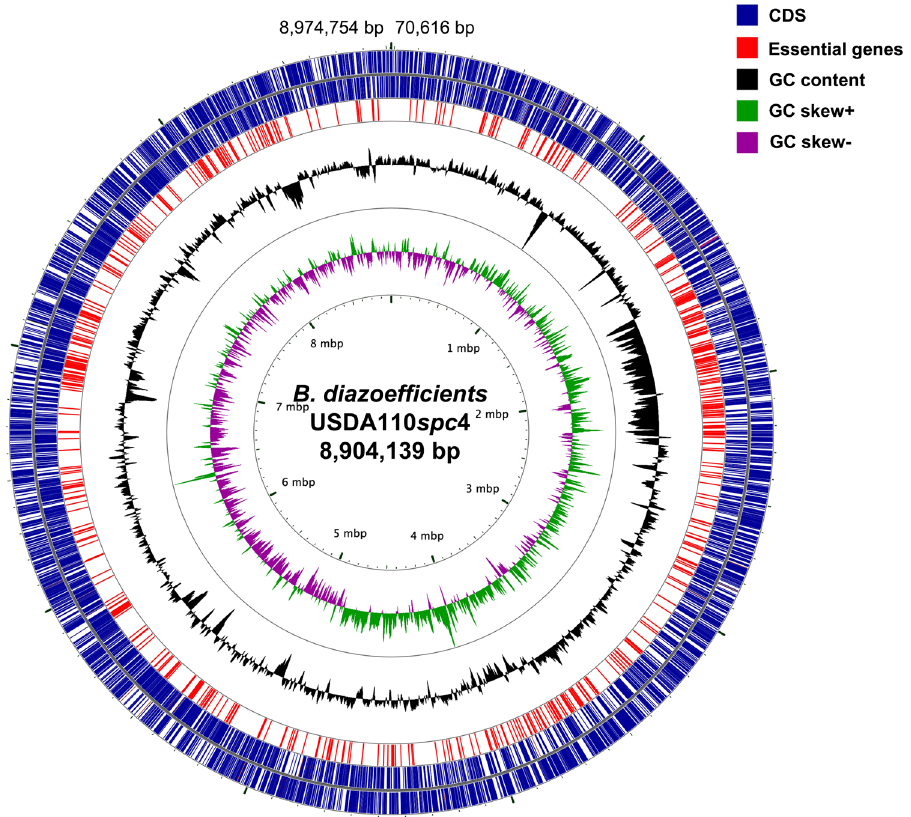
Figure 1. The chromosomal distribution of essential genes in B. diazoefficiens 110 spc4 . These were mapped to the USDA110 genome. The sequenced genome of B. diazoefficiens USDA110 was reported to be 9,105,828 bp 6 . In the figure, we have removed nucleotides spanning the region from 8,974,754 to 70,616 bp of the originally sequenced genome (as indicated by the numbering at the top of the figure), as we now know that these have been deleted from Bd110 spc4 14 . For this reason, we have labeled the genome as USDA110 spc4. From the outside in, the plus strand of CDS, the minus strand of CDS, location of essential genes, GC percentage and GC skew. Essential genes are shown in